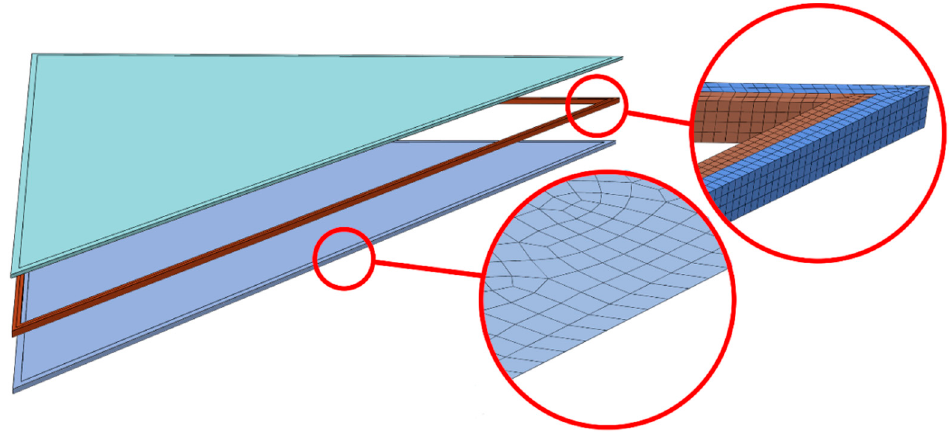
Figure 15. Overview of the triangular unit under analysis–geometry, make-up and example mesh-